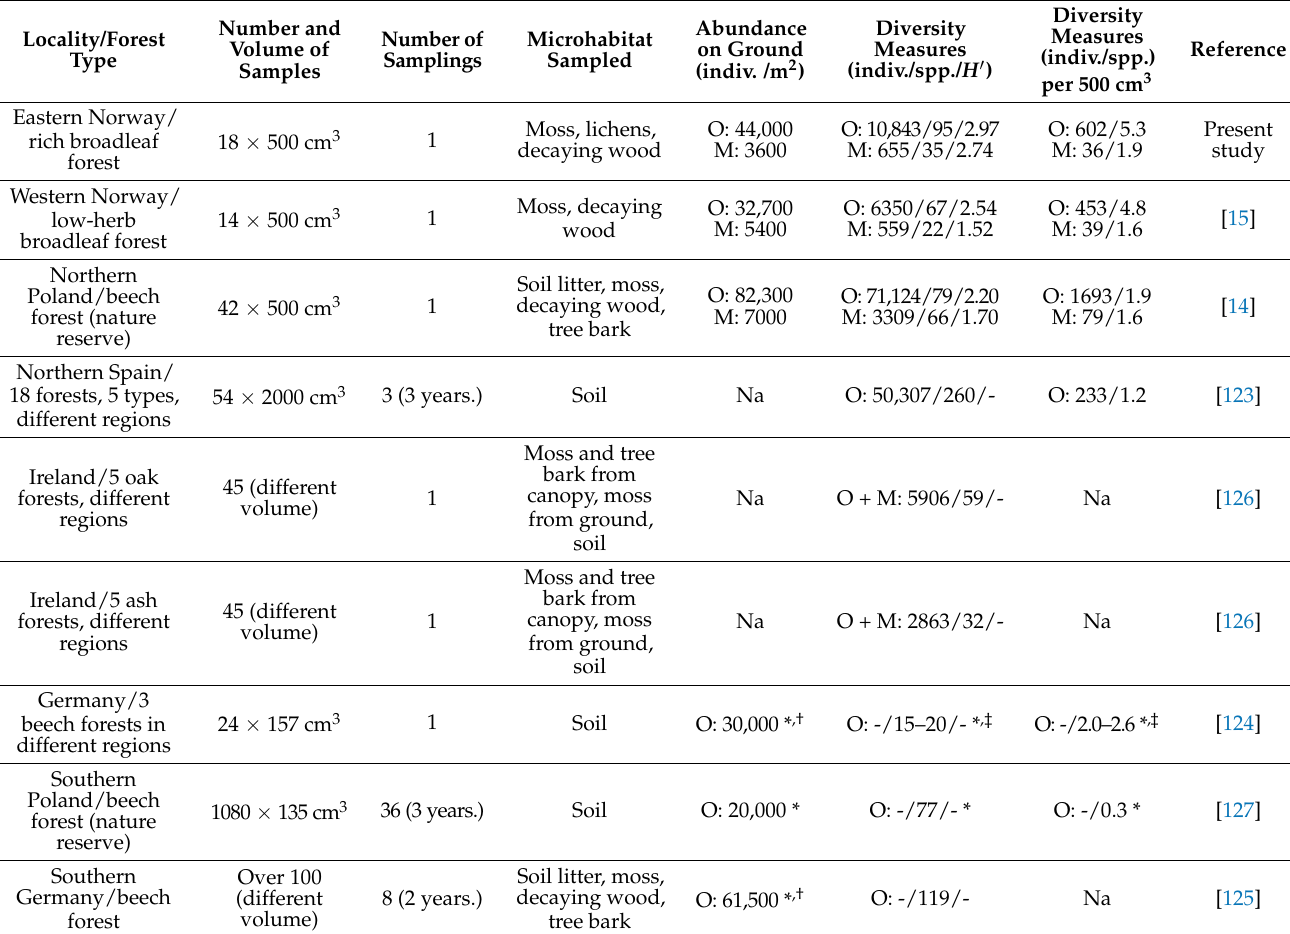
Table 3. Abundance and diversity of mites in broadleaf forests studied in Europe; O—Oribatida, M—Mesostigmata; Na—data not